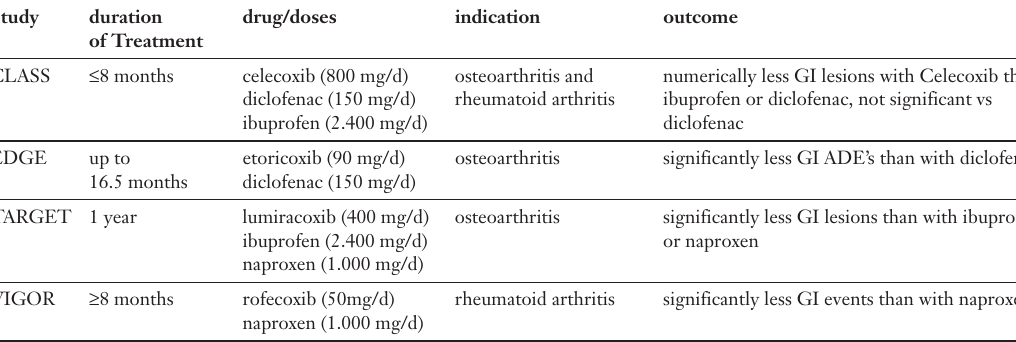
Table 2 Coxibs show less gastrointestinal (GI) toxicity than tradi- tional NSAID’s in large outcome trials. The effect is signi- ficant in EDGE, TARGET and